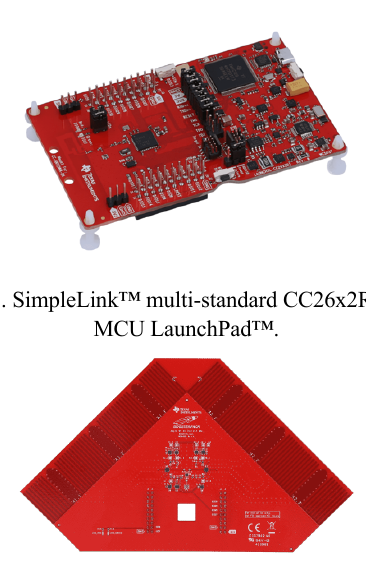
Figure 3 . SimpleLink™ Angle of Arrival BoosterPack.